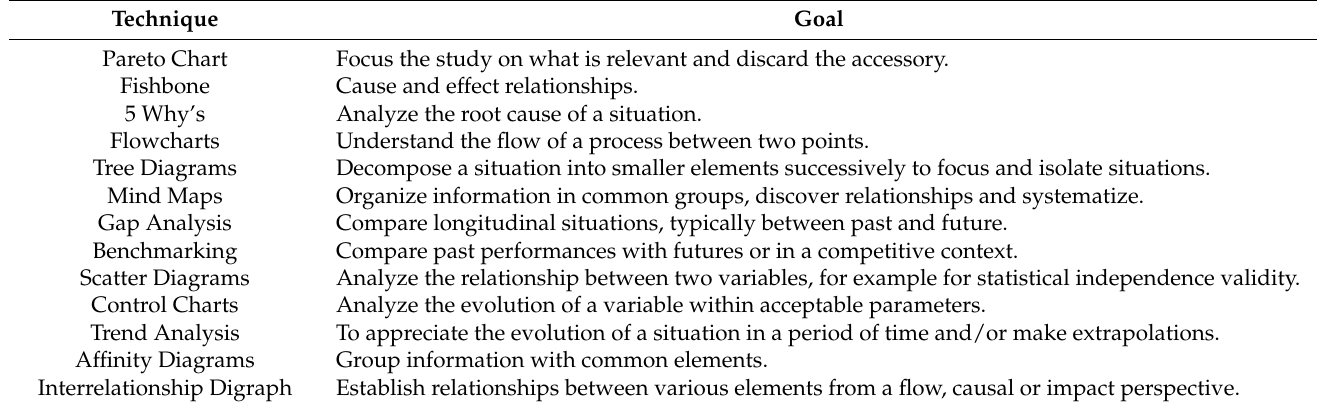
Table 1. Summary of Data Representation Techniques adapted from [26].